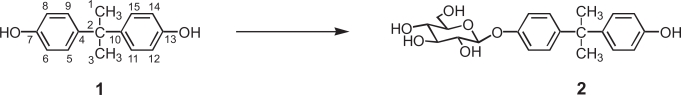
Glycosylation of bisphenol A (1) by free suspended and immobilized Pavlova cells.